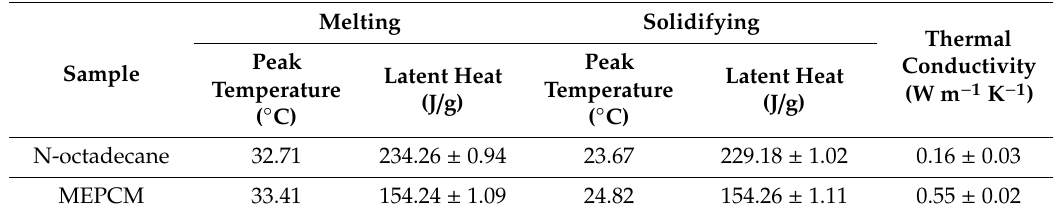
Table 1. Thermal characteristics of the n-octadecane and MEPCM.